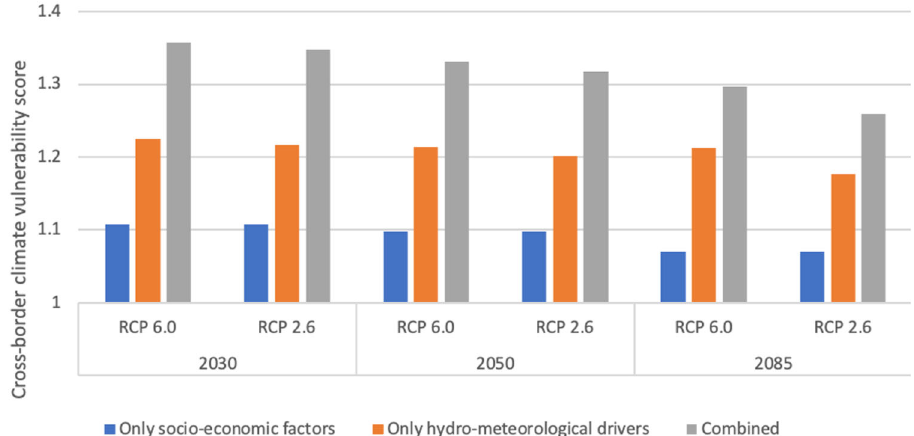
Fig. 1 Cross-border climate vulnerability score (CCVS) of the EU ’ s agri-food economy to drought for 2030, 2050, and 2085 under RCP 2.6 and RCP 6.0 concentration pathways. The blue bars show CCVSs when only socio-economic drivers are taken into account; the orange bars when only hydro- meteorological drivers are taken into account; and the gray bars when both drivers are taken into